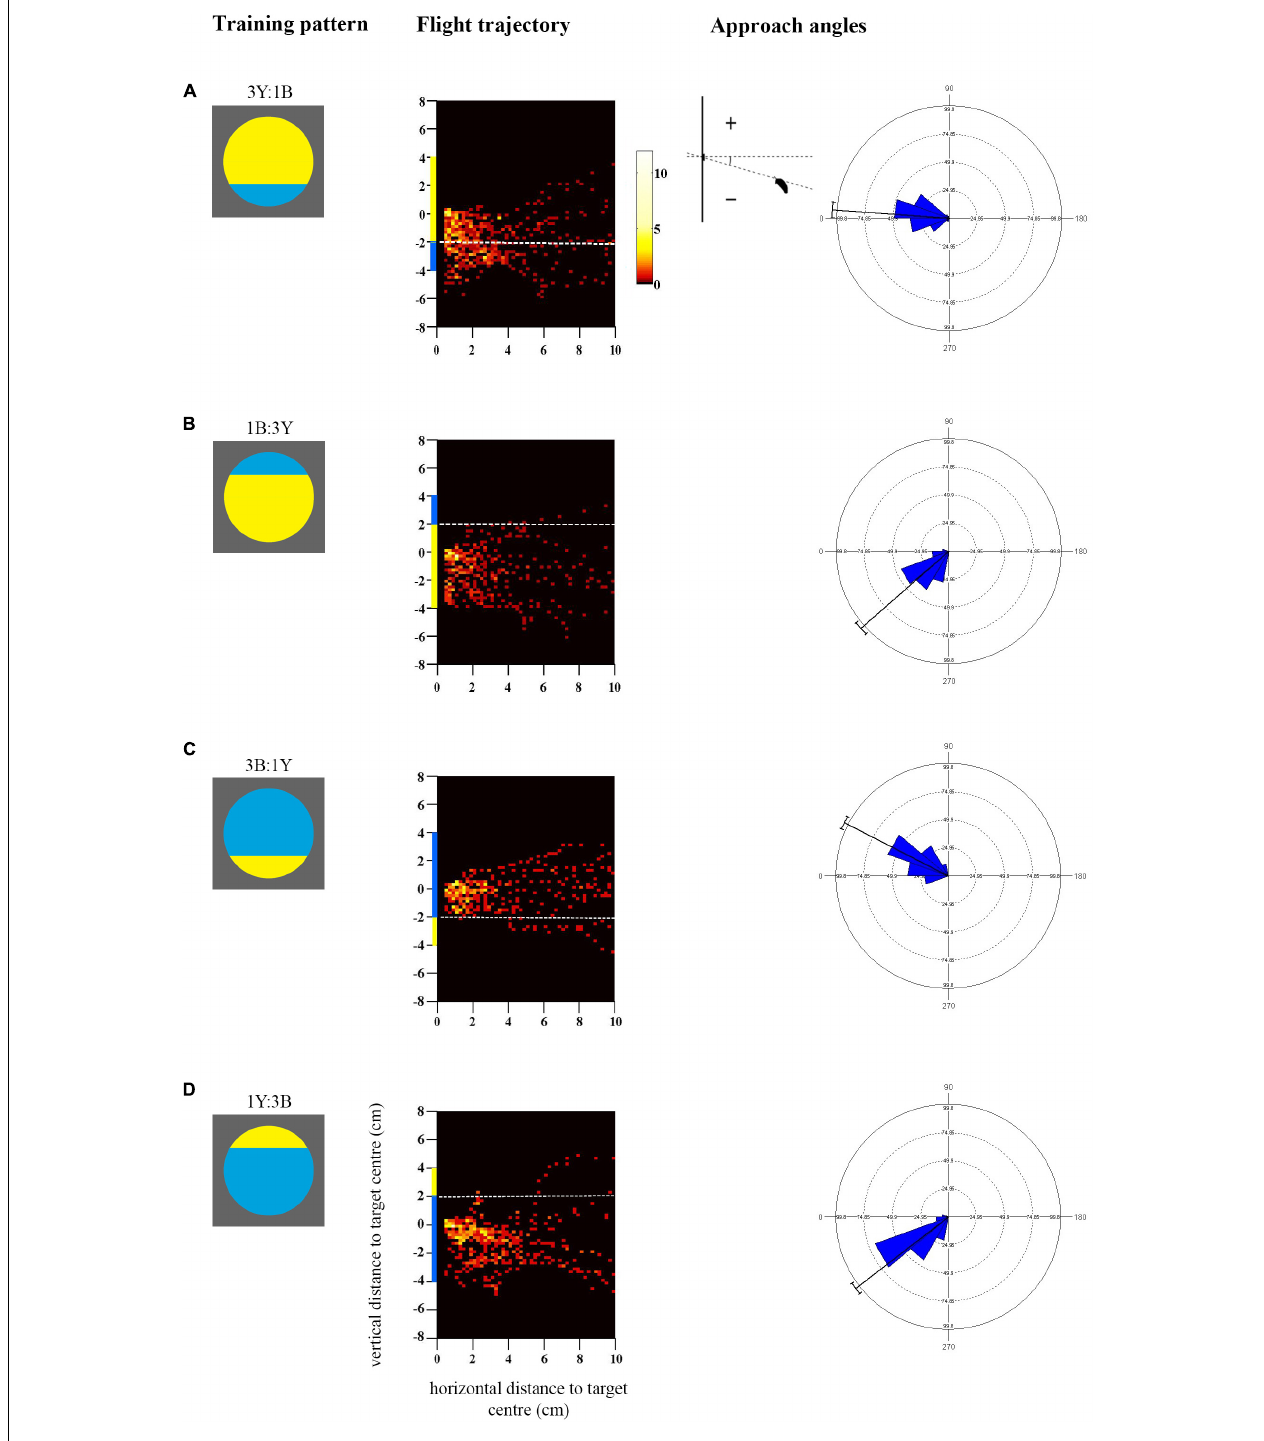
FIGURE 3 | Approach flights of bees trained to collect sucrose from the centre of bicoloured patterns with an off-centre contrast line over a distance of 10 cm up to 0.5 cm. Training patterns were (A) 3Y:1B (mostly yellow) pattern with the contrast line and a blue segment in the bottom half or (B) 1B:3Y in the top half of the target, or (C) 3B:1Y (mostly blue) pattern with the contrast line and yellow segment in the bottom half or (D) 1Y:3B in the top half of the target. As in Figure 1 , the heat maps depict the position of the bees during the last training flight before tests ( N = 10 bees for all groups). White dotted lines indicate the position of the contrast line. X -axis depicts horizontal distance and Y -axis vertical distance to the target plane. Approach angle plots show the angle between the head position of the bee and the contrast line.